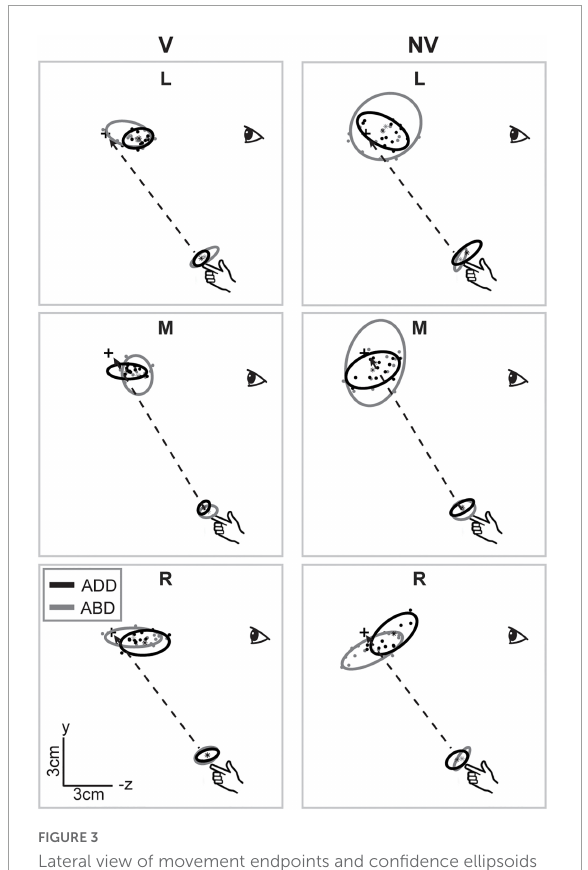
FIGURE3 Lateral view of movement endpoints and confidence ellipsoids for reaches to each target for the participant shown in Figure 2 . Dashed lines show the straight-line paths to each target. In the V condition, axes of maximum variability appeared to be better aligned with sight lines to the targets than with planned movement directions (dashed lines). In the NV condition, these axes were not consistently aligned with either planned movement directions or lines of sight. Ellipsoid size, shape, position, and orientation also appeared to vary more with arm posture in the NV condition, particularly for targets L and M.